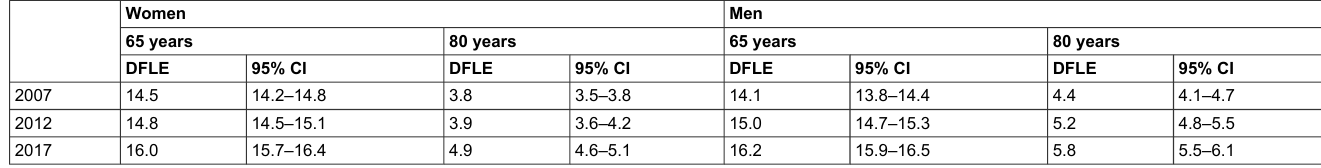
Table S1: Disability-free life expectancy (DFLE) and confidence intervals (95% CI) at age 65 years and 80 years, in women and men, years 2007–2012–2017.